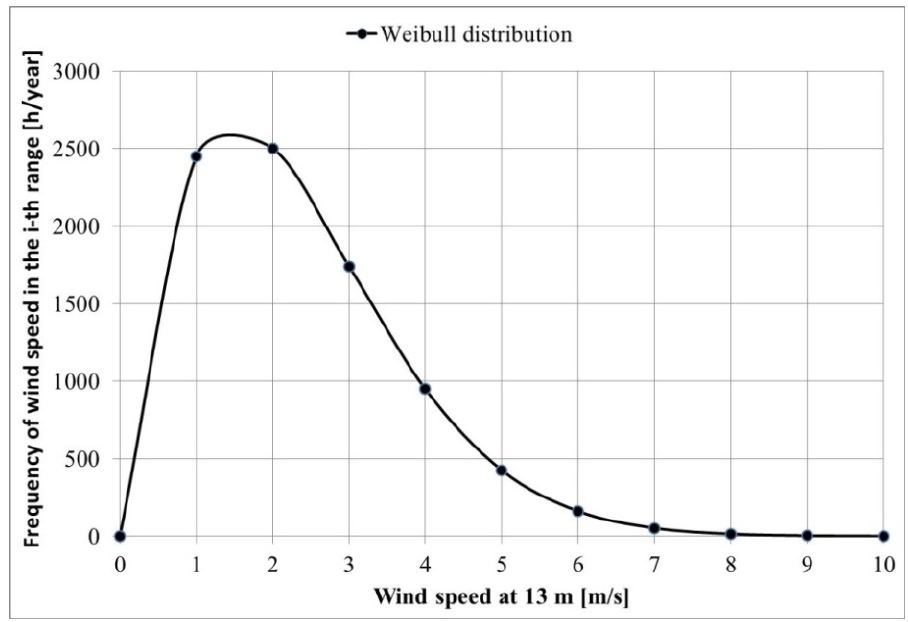
Figure 7. The Weibull distribution for the anemometer at 13 m above ground level for location III.